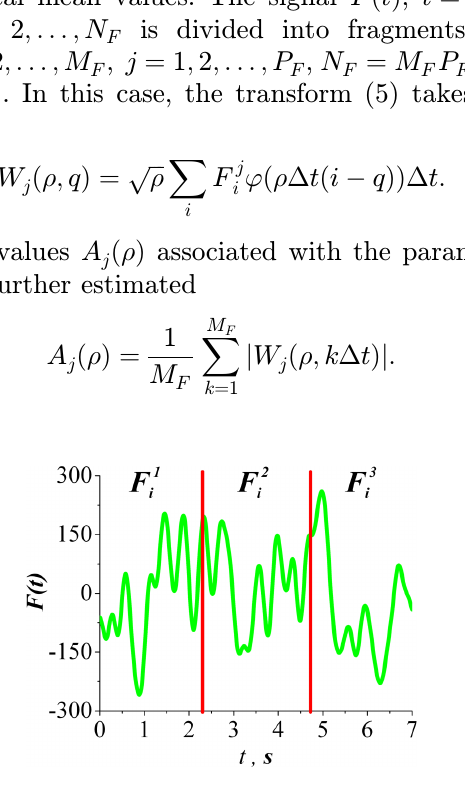
Fig. 3. Fragmentation of the analyzed